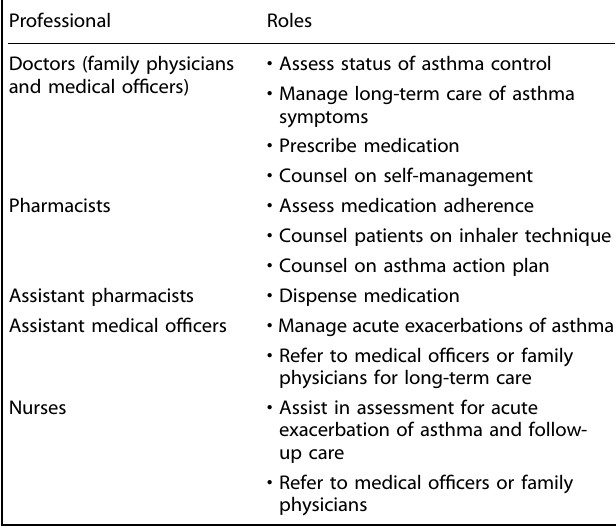
Table 2. Healthcare professional roles in the provision of asthma management services within public healthcare clinics. Professional